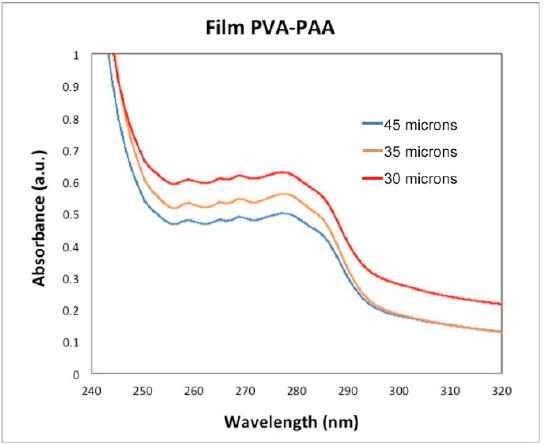
Figure 7. Absorbance as a function of wavelength for three PVA/PAA films with different thickness.